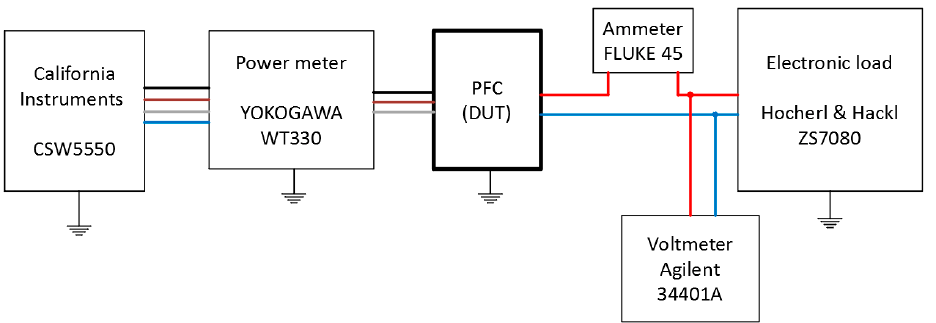
Table 1. Designation type of used laboratory equipment. Figure 3. Block diagram of the experimental measurements.